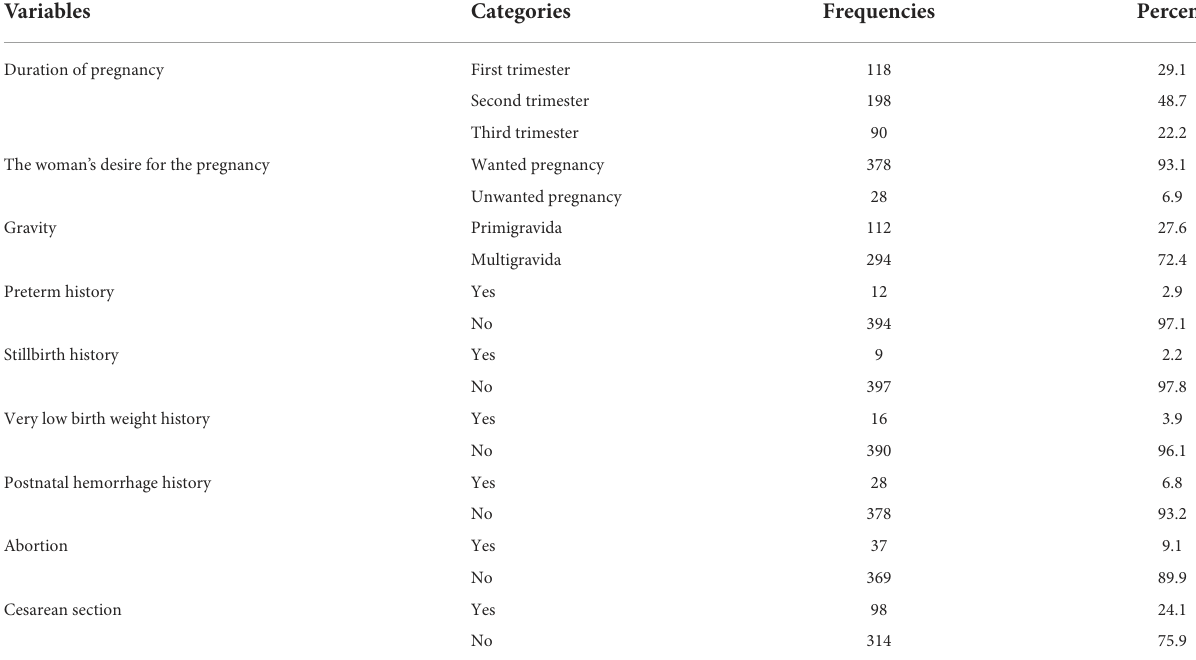
TABLE 3 Previous obstetrics and pregnancy-related characteristics of pregnant women attending antenatal clinic follow-up at Bedelle general hospital and Metu Karl comprehensive specialized hospital, 2021 ( N = 406).